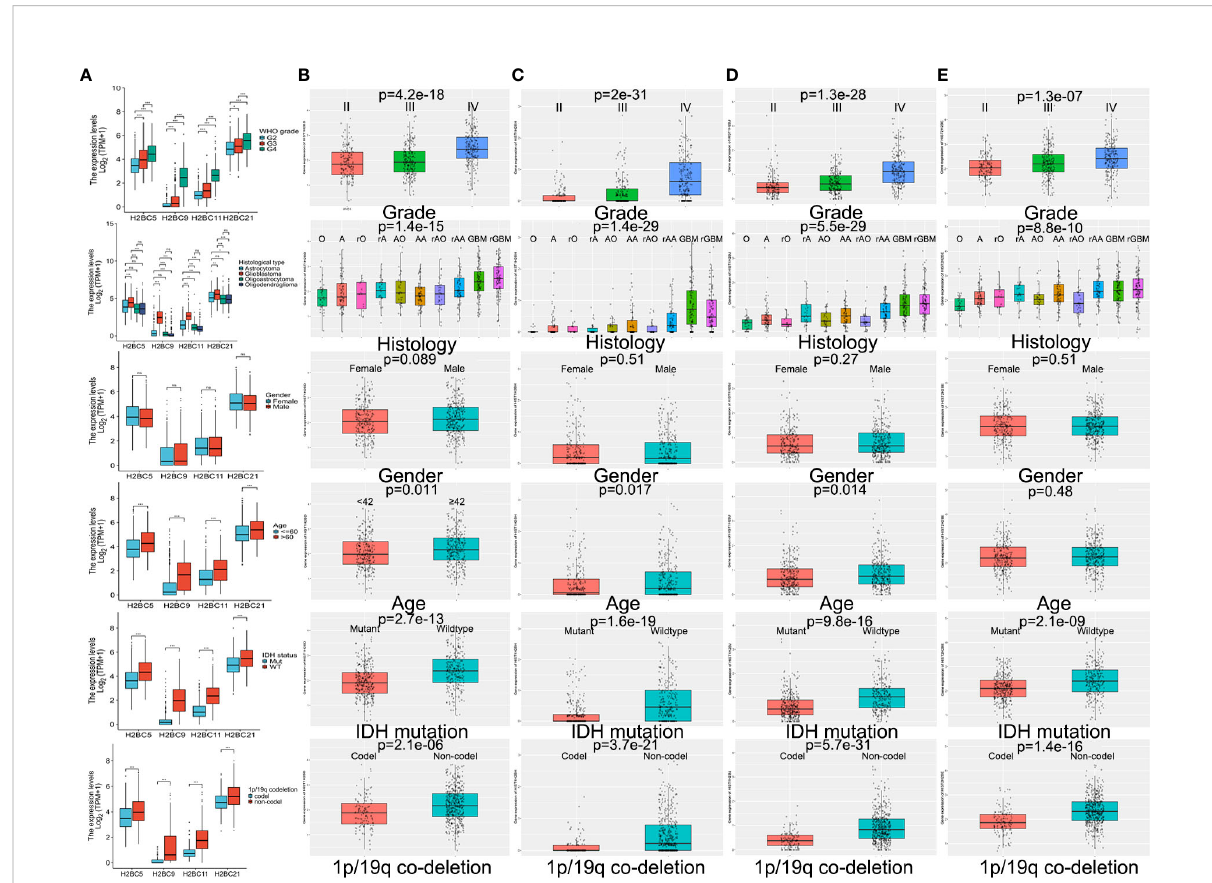
FIGURE 5 In fl uence of various factors on gene expression using TCGA and CGGA data. In fl uence of WHO grade, histology, IDH status, 1p/19q codeletion, gender, and age on H2B gene expression in (A) TCGA and (B – E) CGGA. P<0.05 is considered statistically signi fi cant. *P < 0.05, **P < 0.01, ***P < 0.001, ns, no signi fi